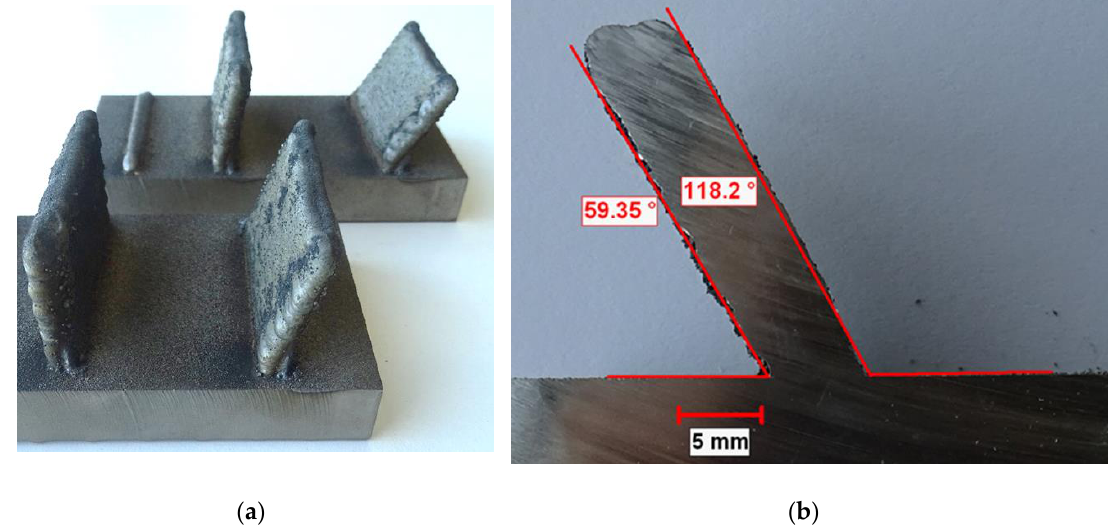
Figure 14. Inclined walls manufactured with the four-stream nozzle employing Strategy A: ( a ) wall angles of 60°, 70°, 80°, and 90°; ( b ) cross-section of the wall at an inclination of 60°. Table 6. E ffi ciency and MDR results obtained with di ff erent nozzles, strategies, and wall angles (note that the walls that failed are marked with an “X” and walls obtained at 900 mm · min − 1 are marked with *). θ ( ◦